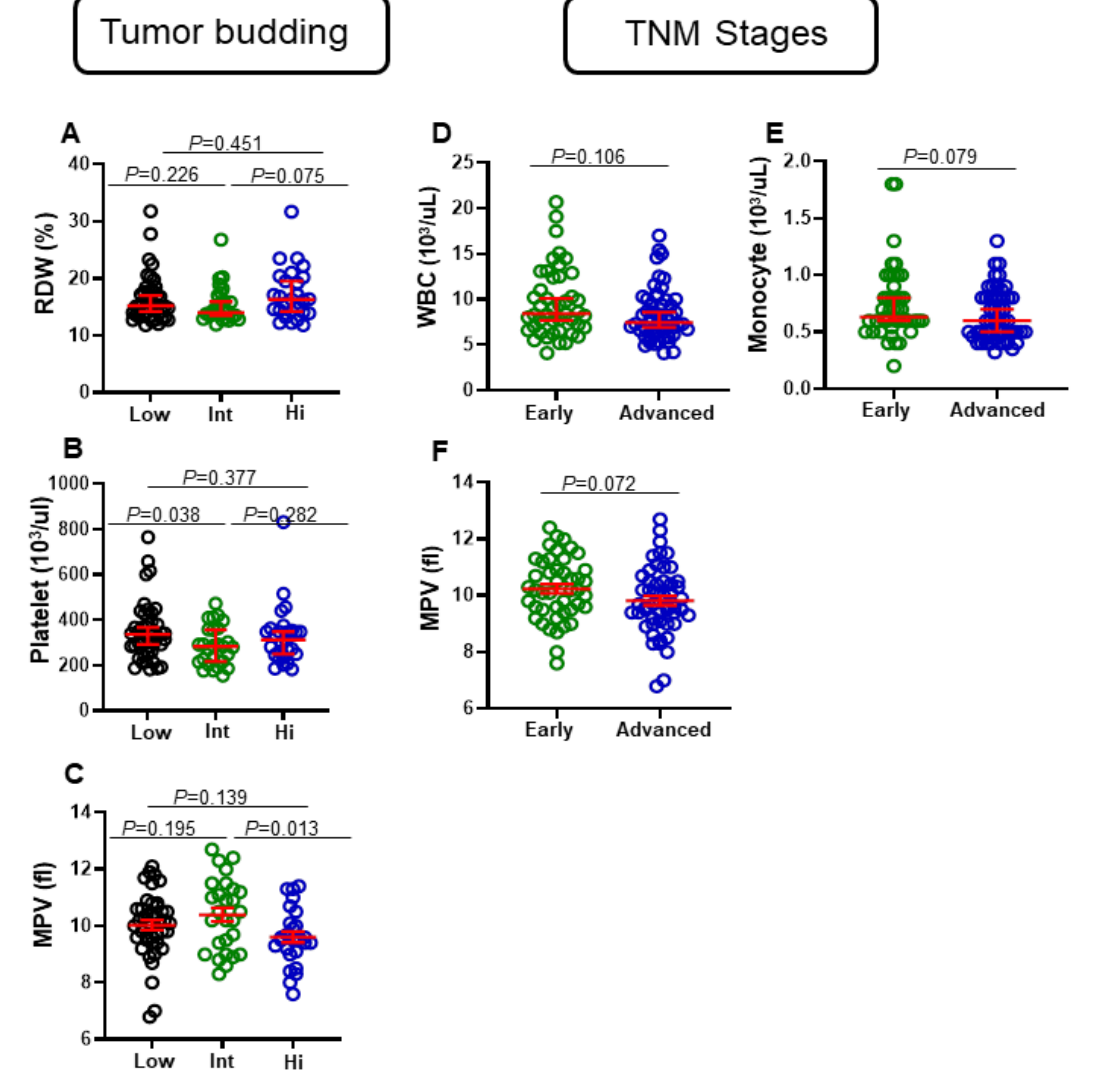
Figure 1. Comparison of some CBC parameters based on tumor budding and TNM stages of CRC patients. Patients were divided into three groups based on degree of tumor budding: low, intermediate, and high. Scatter plots show differences in levels of RDW ( A ), platelets ( B ), and MPV ( C ). Additionally, patients were divided into two groups based on TNM stages (early and advanced). Scatter plots show differences in levels of WBCs ( D ), monocytes ( E ), and MPV ( F ). Red lines represent median ± 95% CI or mean ±